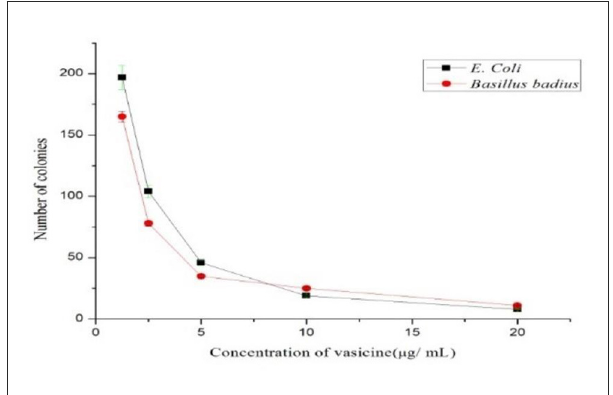
FIGURE3 Anti-microbial Activity of vasicine for E. coli and Bacillus badius